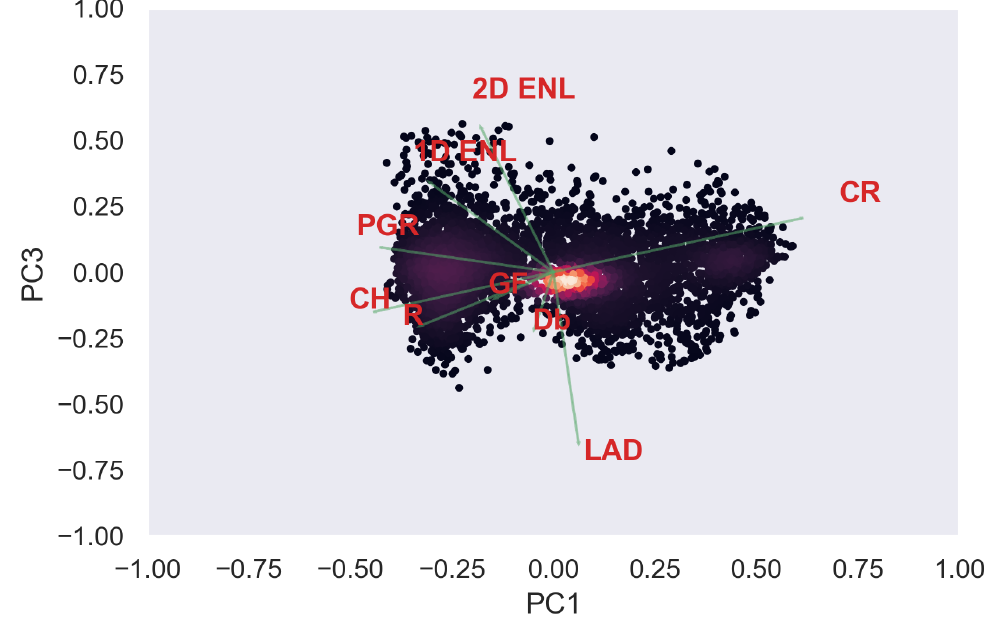
Figure A35. ULS PCA band 1 and 3 loadings at 1m grid size.